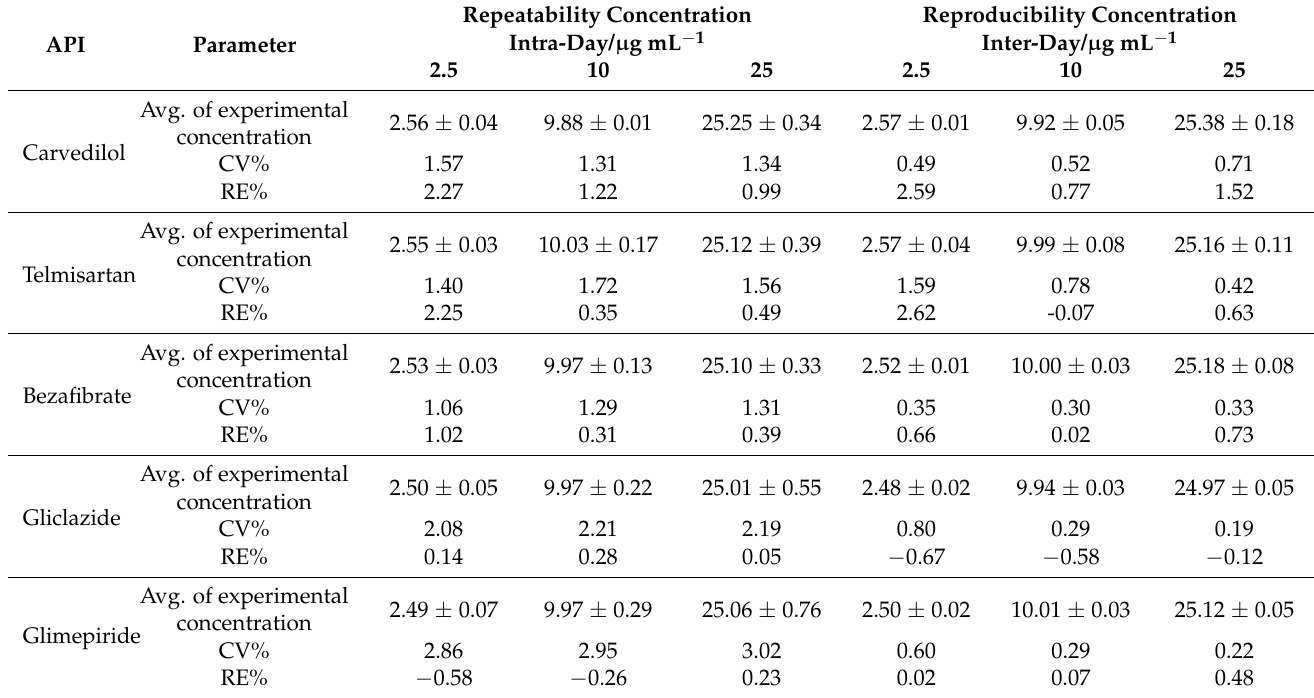
Table 3. Results of precision (CV%) and accuracy (RE%) of active pharmaceutical ingredients (API).